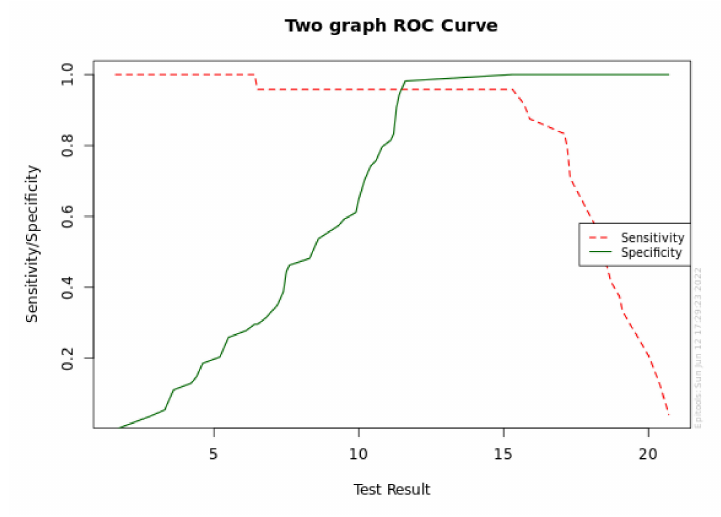
Figure 4. Sensitivity and specificity graph for a-MMP-8 level at T1.